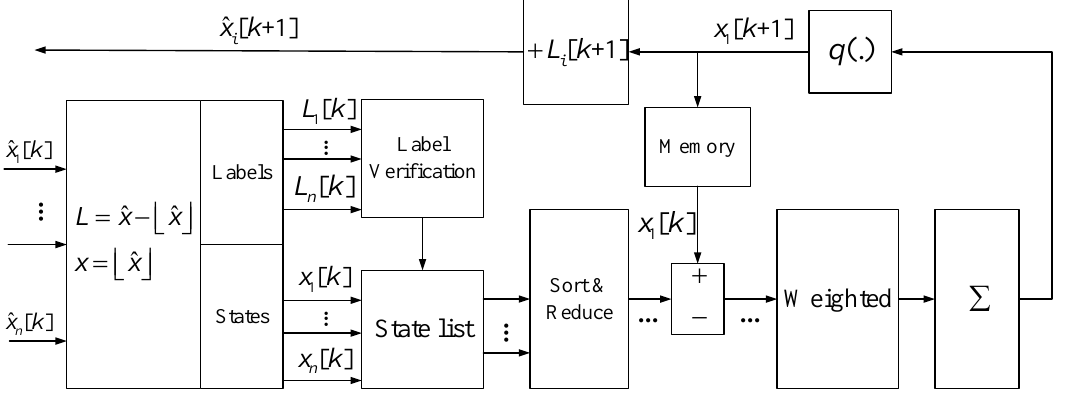
Figure 4. Data flow model of QWL-MSR for node i